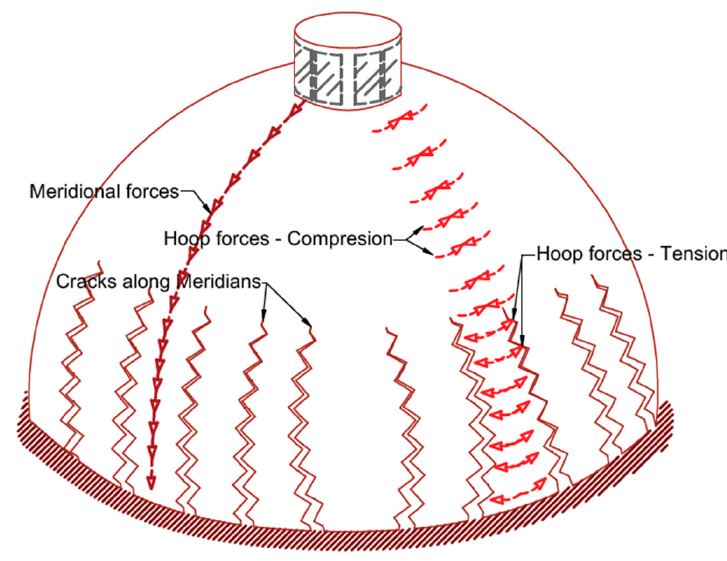
Figure 4. The behavior of a spherical dome under gravity